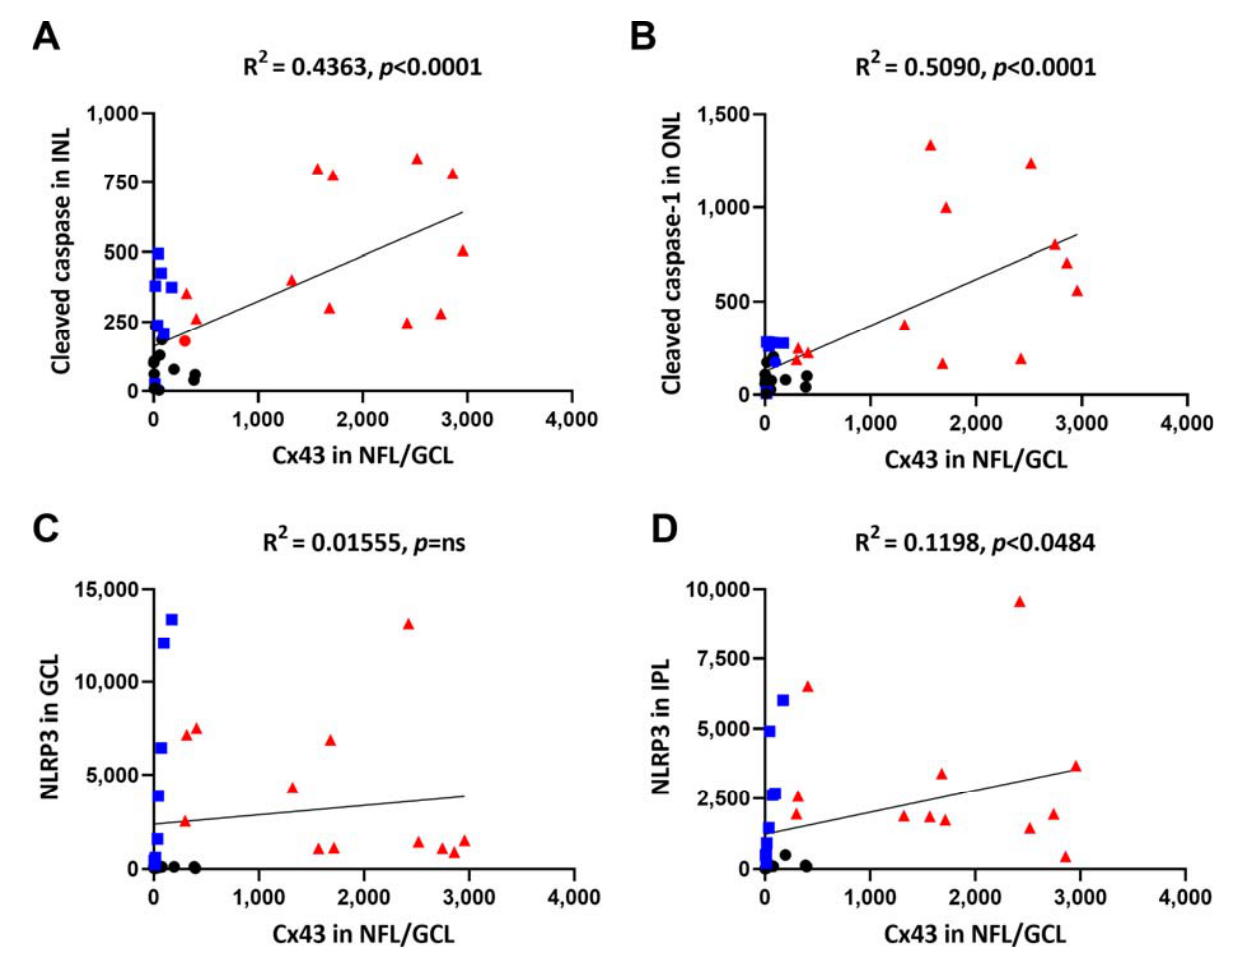
Figure 7. Simple linear regression between Cx43 in the NFL/GCL and cleaved caspase ‐ 1 in the INL and ONL, as well as NLRP3 in the NFL/GCL and IPL. ( A , B ) Cx43 expression in the NFL/GCL showed a positive linear correlation with cleaved caspase ‐ 1 expression in the INL and ONL. ( C , D ) Cx43 in the NFL/GCL did not correlate with NLRP3 in the NFL/GCL and showed a weak positive linear correlation with NLRP3 in the IPL; black circle = CTL, blue square = DM, red triangle = DR ns = no significant difference.